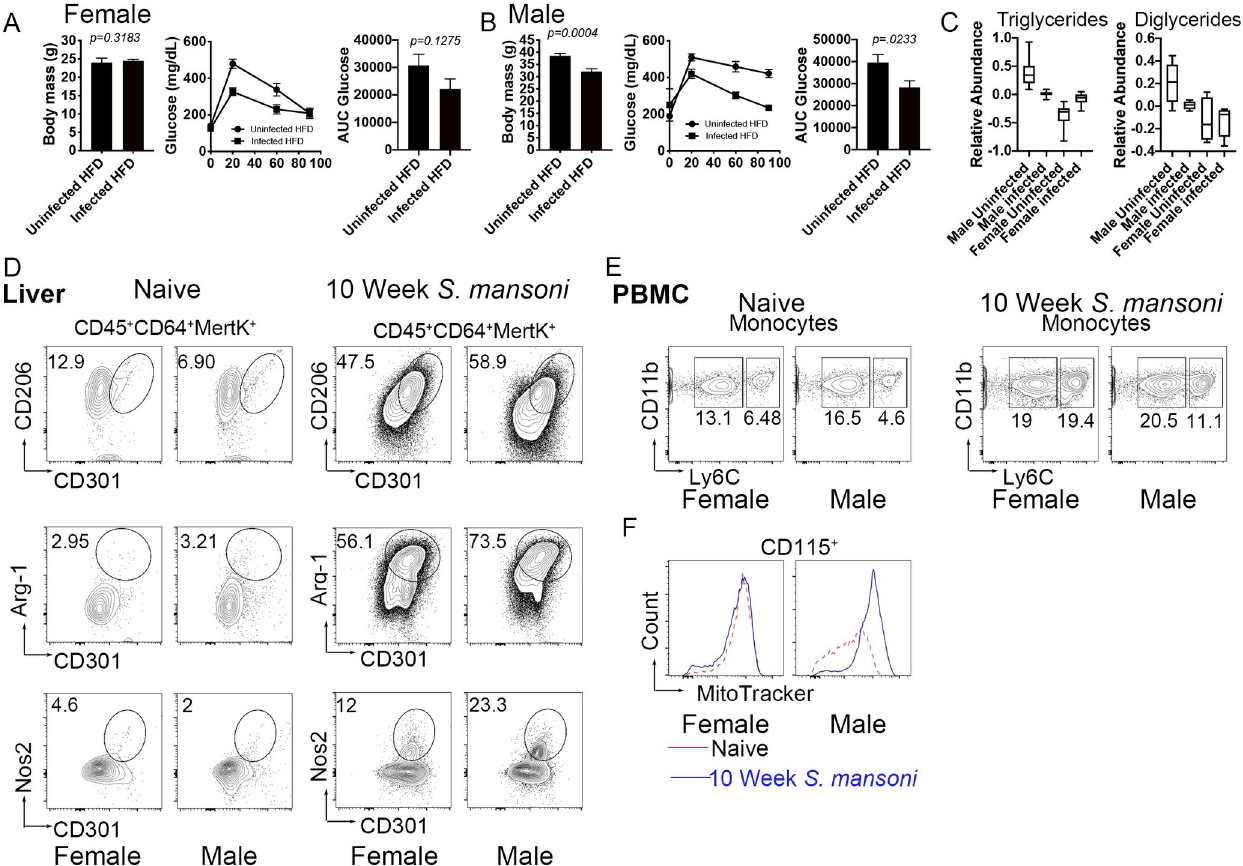
Fig 6. S . mansoni infection does not protect females from metabolic disease despite inducing alternative activation in hepatic macrophages. (A-B) Total body weight and glucose tolerance test (GTT) at 10 weeks post-infection. GTT values were analyzed by Area Under the Curve and graphed using GraphPad Prims. (C) Plots of relative abundance of serum di/triglycerides measured by LC-MS (D) Flow cytometry analysis of alternative activation markers CD206 and CD302 in perfused and digested livers gated on hepatic macrophages (CD45 + CD64 + MertK + ) Arg-1 expression in hepatic macrophages from uninfected and infected ApoE -/- mice Nos-2 expression by flow cytometry in hepatic macrophages 10 weeks post infection. (E) Ly6C expression in monocyte from peripheral blood mononuclear cells (PBMC) at 10-week post infection by flow cytometry (F) MitoTracker Red in CD115 + monocytes from PBMC at 10 weeks post immunization in uninfected and infected ApoE -/- mice. Graphs are representative from experiments that were performed 3–4 times with n > 4. Exception is MitoTracker data, which was performed twice, with n > 4. Statistical analysis was done using unpaired Student’s t test, � p < 0.05; �� p < 0.01.